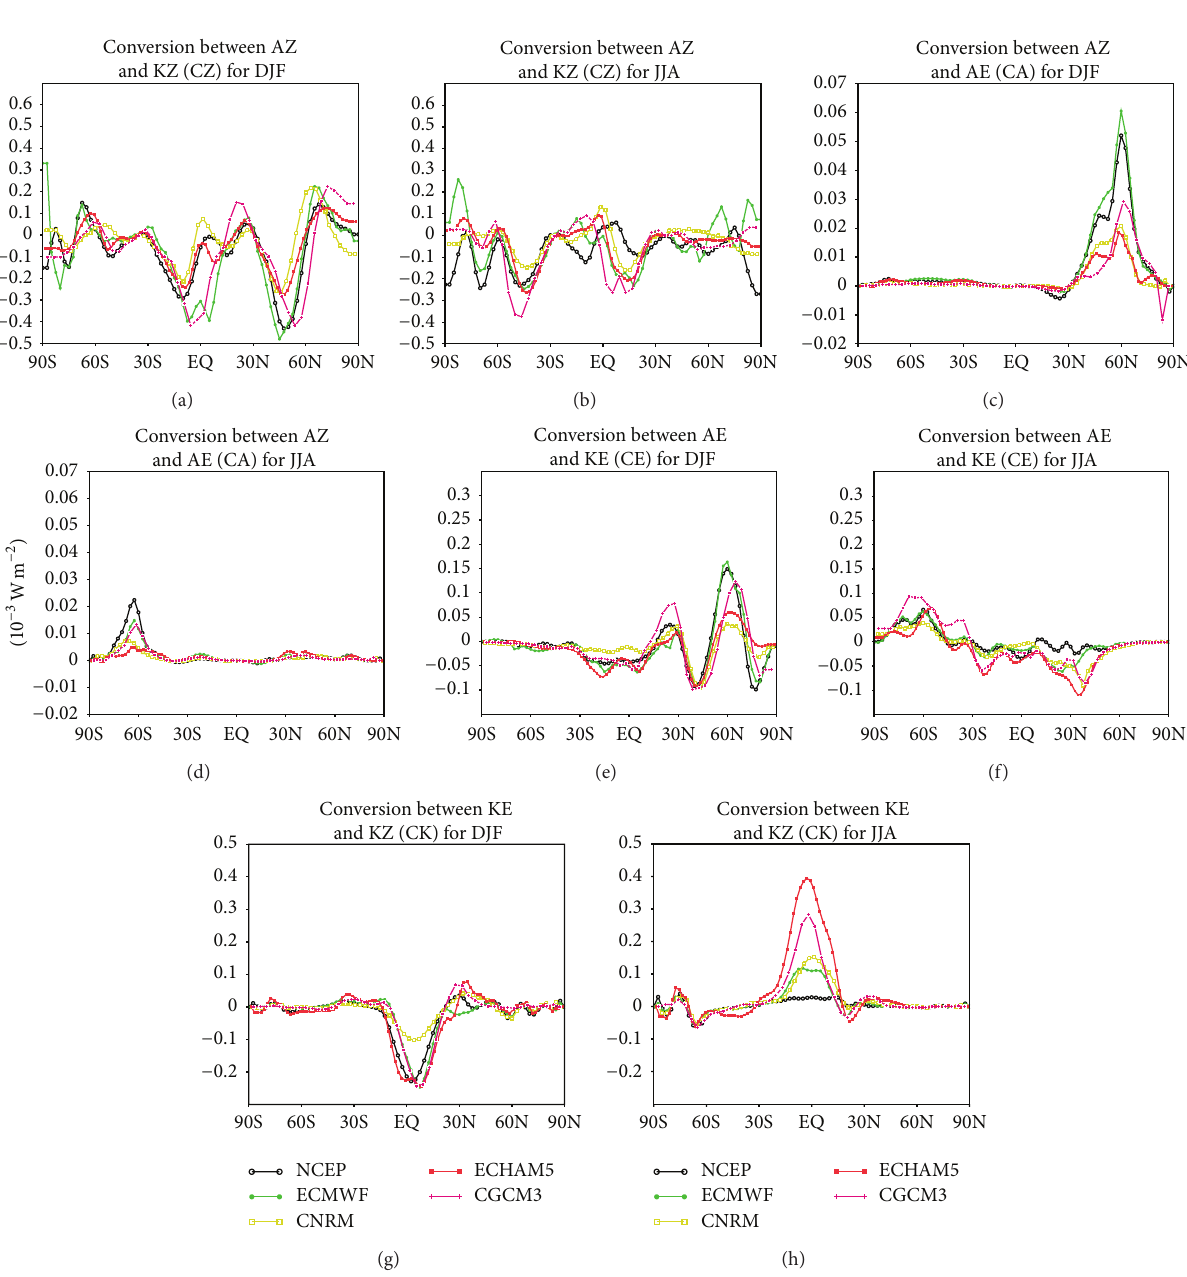
Figure 5: Latitudinal distribution of volume integrated conversion between AZ and KZ (CZ) for DJF (a) and JJA (b), conversion between AZ and AE (CA) for DJF (c) and JJA (d), conversion between AE and KE (CE) for DJF (e) and JJA (f), and conversion between KE and KZ (CK) for DJF (g) and JJA (h) averaged for the period from 1979 to 1999. Units are Wm −2